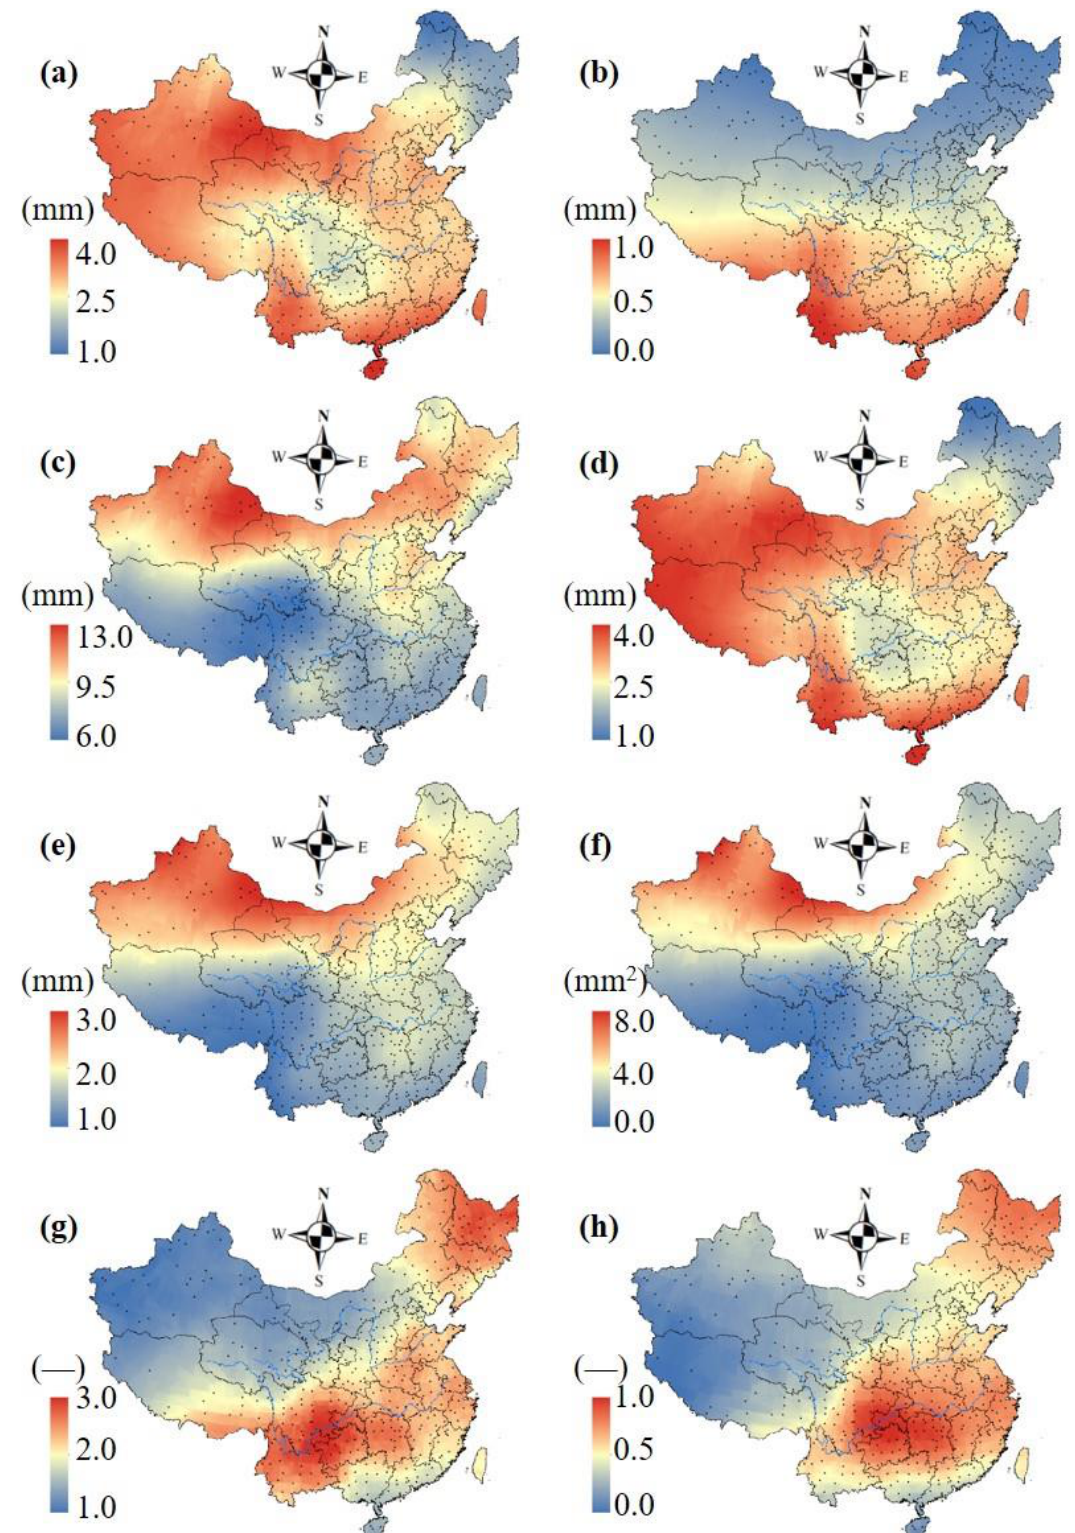
Figure 2. Descriptive statistics of daily ET 0 : ( a ) mean; ( b ) minimum; ( c ) maximum; ( d ) median; ( e ) standard deviation; ( f ) variance; ( g ) kurtosis; and ( h ) skewness.